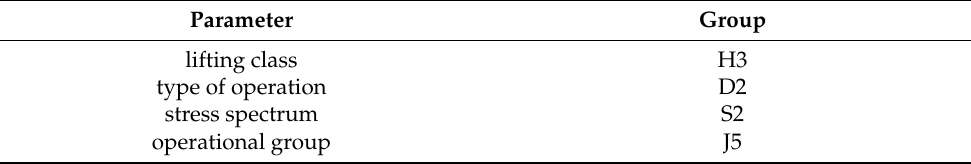
Table 2. The classification of the analyzed crane according to standard STN